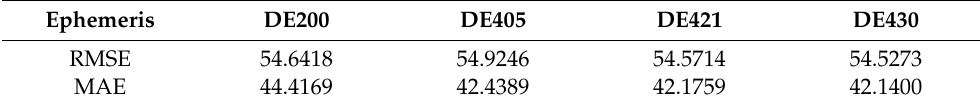
Figure 5. Comparison of timing residuals. The vertical line in the figure represents the mean square error of timing. ( a ) DE200; ( b ) DE405; ( c ) DE421; ( d ) DE430. Table 4. Comparison of RMSE and MAE values (unit: µs).